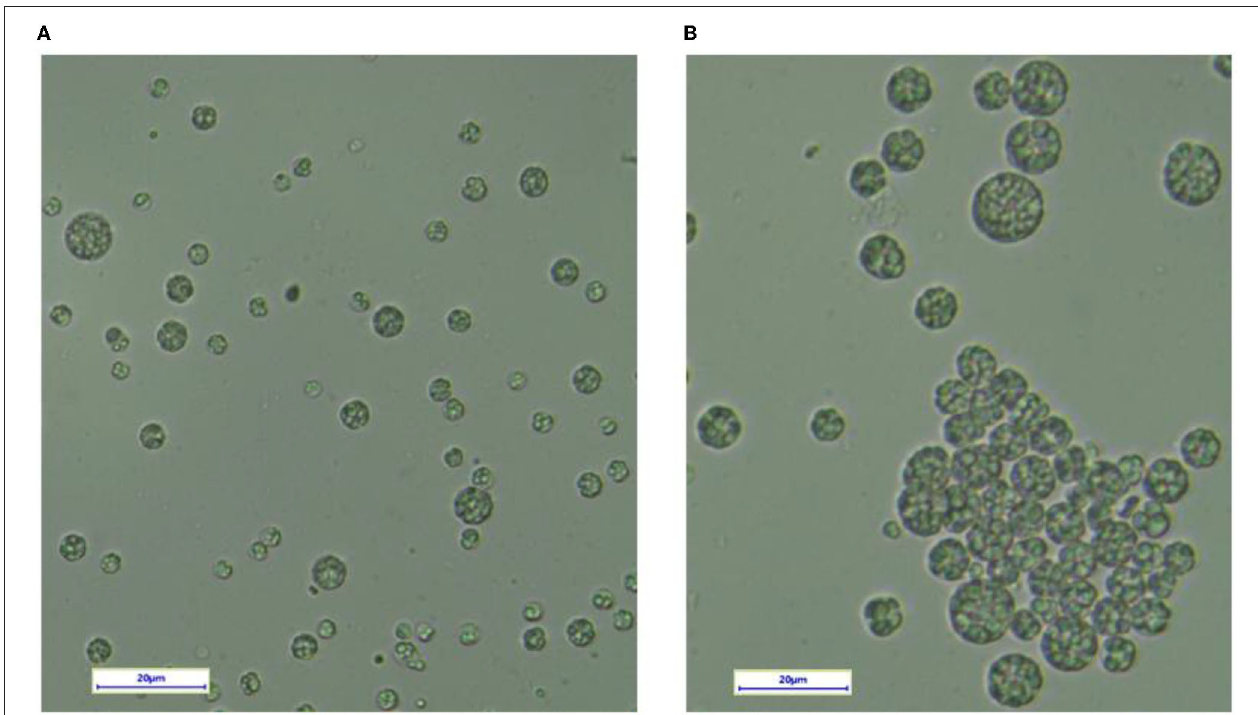
FIGURE 2 | The cellular morphology of (A) SW1 and (B) YHPM1 under the light microscope. The scale bar represents 20 µ